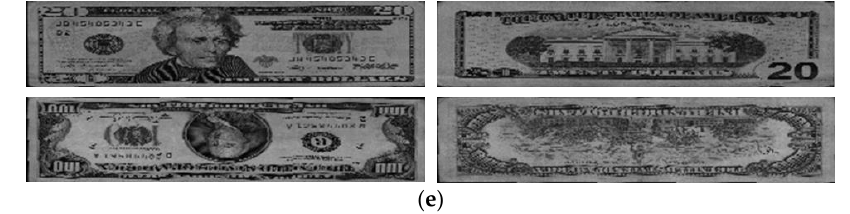
Figure 6. Examples of banknote images used for experiments: ( a ) Chinese yuan (CNY); ( b ) Japanese